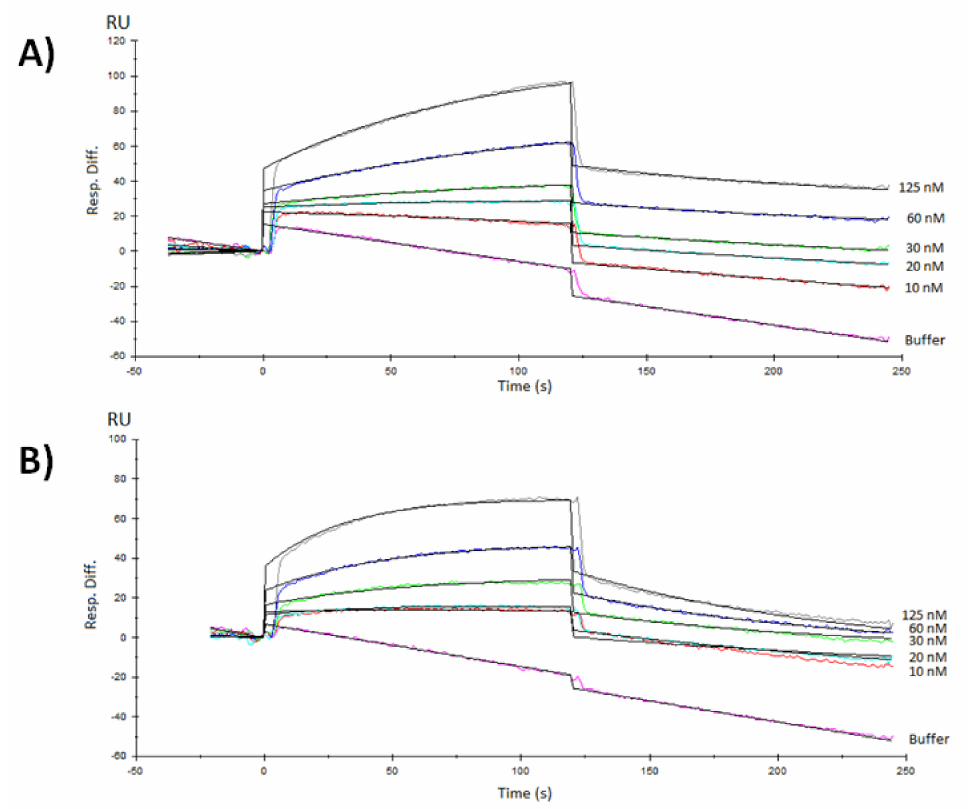
Figure 5. Surface plasmon resonance analysis from RBD recombinant proteins obtained in HEK-293 mammalian cells interacting with mFc-ACE2 cell receptor immobilized by capture in a Protein A sensor chip. ( A ) Sensorgrams of one of the replicates of the RBD-CD chimeric protein dissolved in PBS, pH 7.2. ( B ) Sensorgrams of one of the replicates of the RBD-H6-HEK tagged protein also dissolved in PBS, pH 7.2. Each color curve corresponds to the protein concentration indicated on the right edge. Black lines are the curves of the Langmuir 1:1 fitting, with drifting baseline (Chi 2 ≤